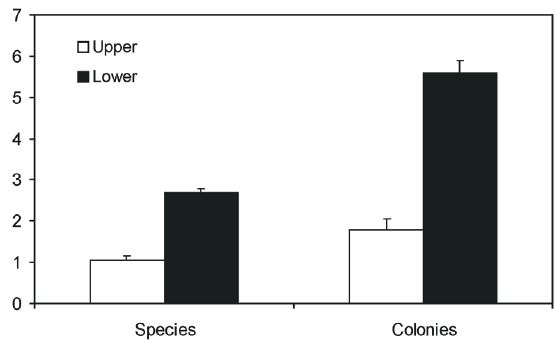
Fig. 2. – Number of bryozoan species and colonies per valve (mean + standard error) on upper and lower valves.